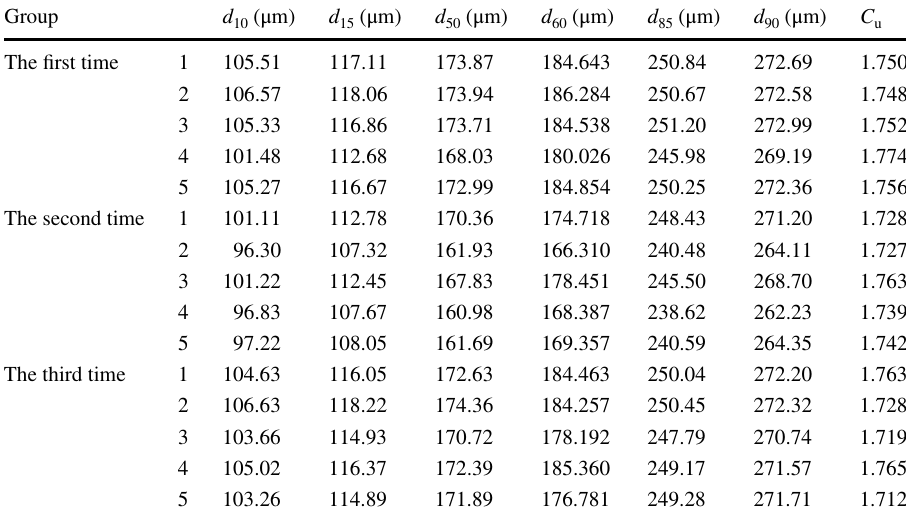
Table 2 Characteristic particle size data of the measured Yellow River